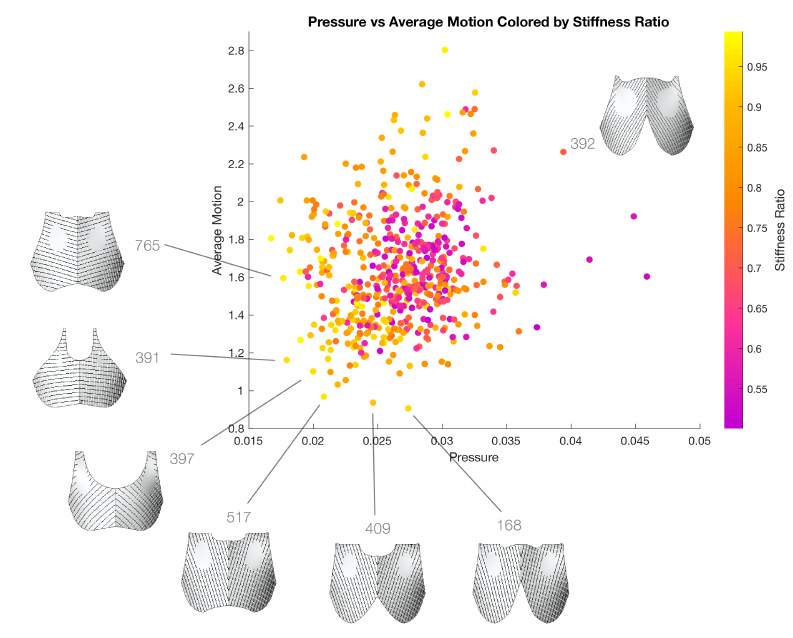
Figure 17. Biobjective plot of generated designs.